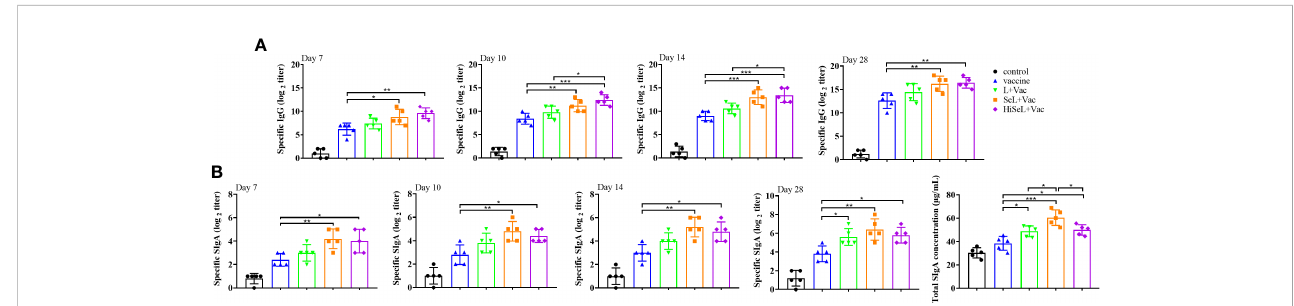
FIGURE 2 Effect of SeL and HiSeL on the humoral immune response and mucosal immune response induced by the immunization of mice. Sera and fecal samples of mice were gathered on days 7, 10, 14, and 28 after immunization to detect speci fi c IgG and SIgA antibody response. Intestinal mucus samples of mice were gathered on day 28 after immunization to detect total SIgA concentration. (A) The titer of speci fi c IgG antibody in mice sera. (B) The titer of speci fi c SIgA antibodies in mice fecal and total SIgA concentration in intestinal mucus. Each experimental group consisted of fi ve mice per group. Data were presented as means ± SD (*P < 0.05, and **P < 0.01). The statistical analysis was performed using one-way ANOVA.